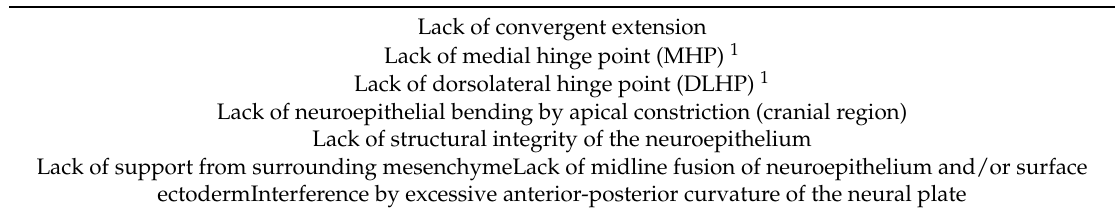
Table 1. Ways in which the neural tube can fail to form.